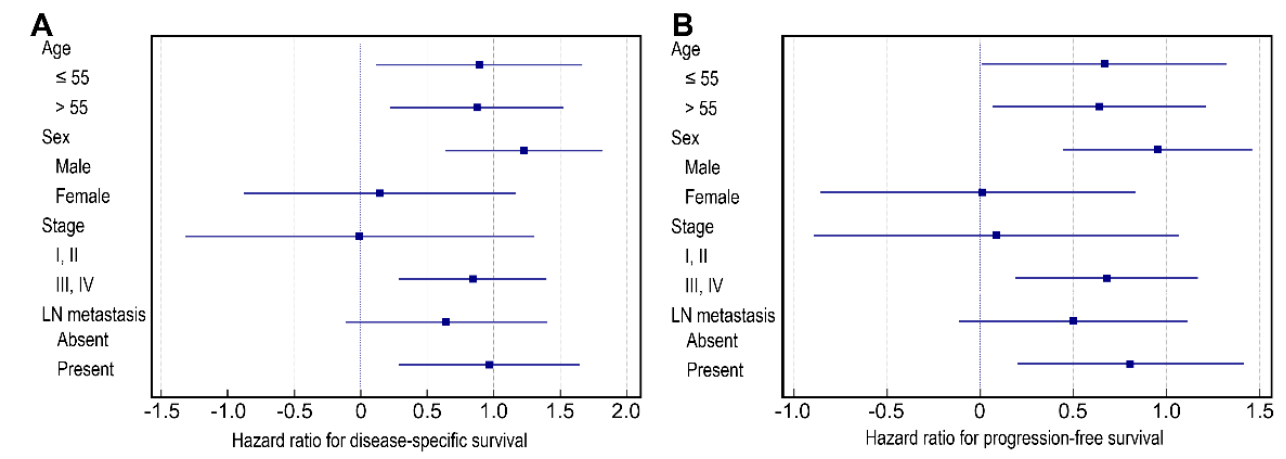
Figure 3. Forest plot of disease-specific survival hazard ratios ( A ) and progression-free survival hazard ratios ( B ) by subgroup. PLR, platelet–lymphocyte ratio; LN, lymph node.